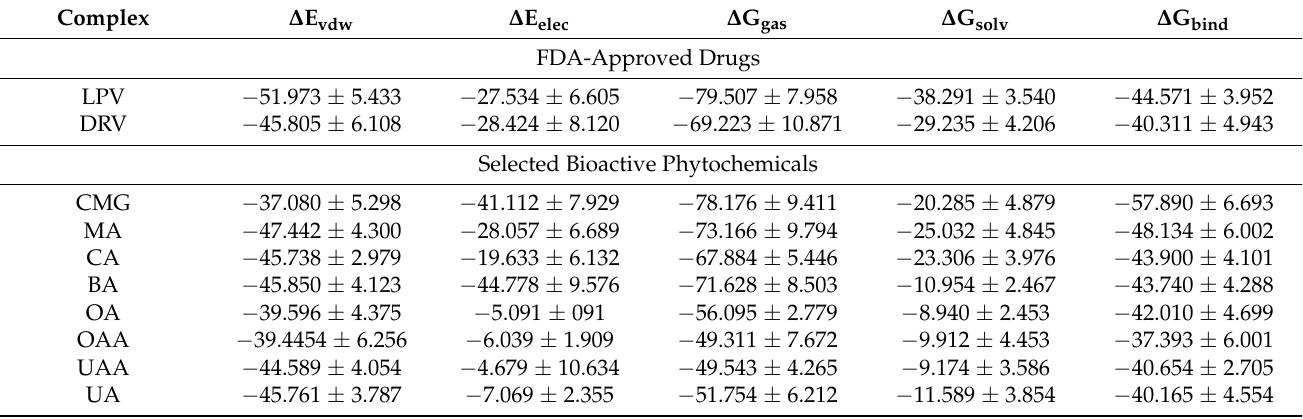
Table 2. Thermodynamic energy components (kcal/mol) for the bioactive compounds and FDA- approved drugs to HIVpro after 350 ns